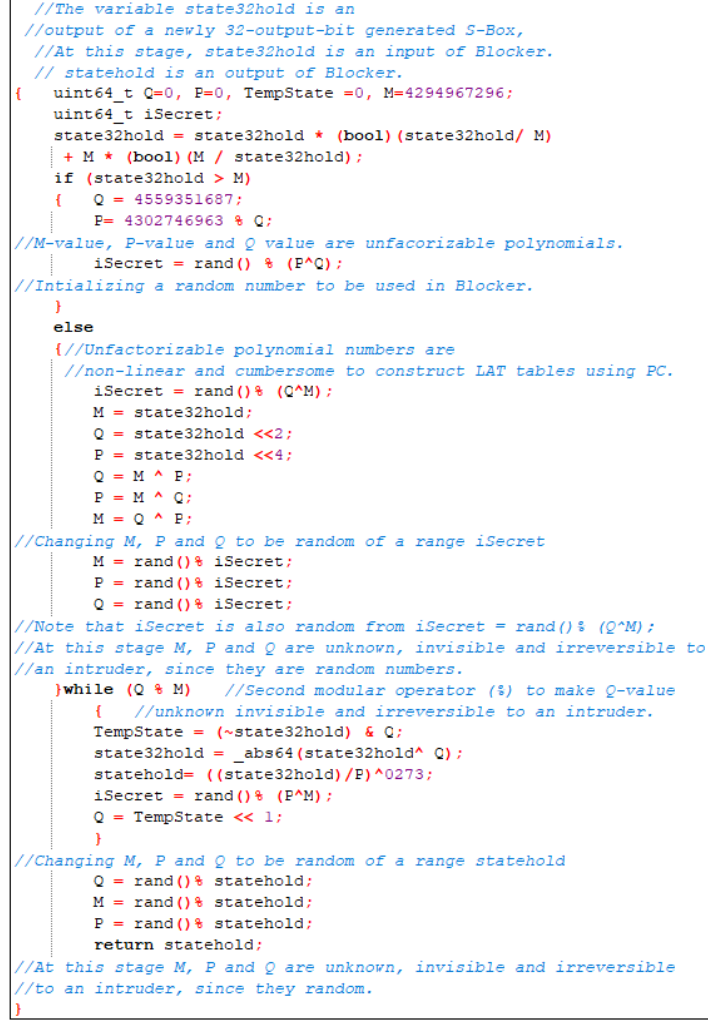
Figure 1. New generated function called